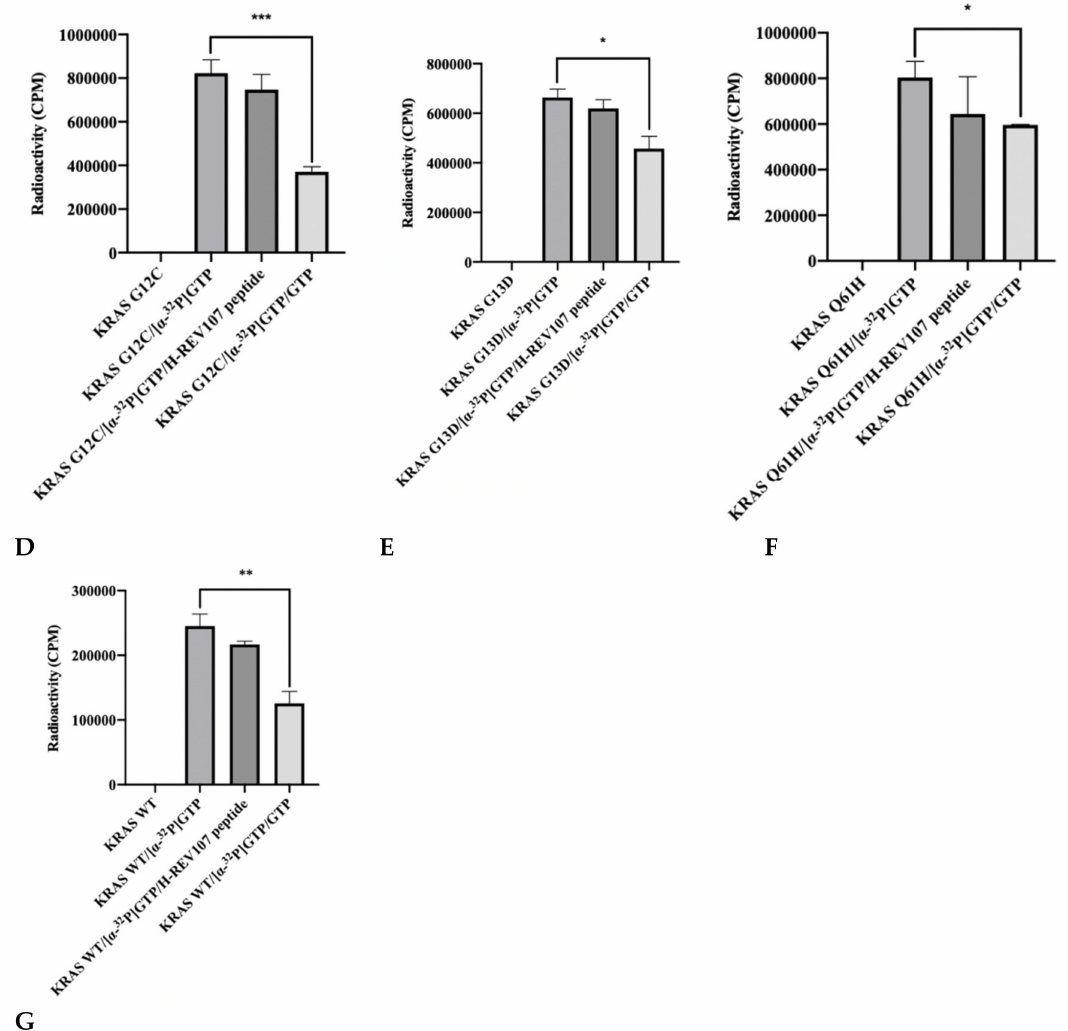
Figure 2. Inhibitor assay of KRAS mutants and H-REV107 protein / peptide. ( A ) The binding of GTP to KRAS mutant (G12V) in the presence of H-REV107 protein was determined using α 32 -labeled GTP. ( B – G ) The binding of GTP to KRAS mutants (G12V, G12D, G12C, G13D, and Q61H) or wild-type in the presence of H-REV107 peptide was determined using α 32 -labeled GTP. The non-bound 32 α -GTP was washed out and the radioactivity was examined using a scintillation counter. Non-labeled GTP was used as a competitor. Data are presented as mean ± SD. Statistic tests were performed using a Student’s t -test. * p < 0.05, ** p < 0.01, and *** p < 0.001 compared to the control under α 32 -labeled GTP (second